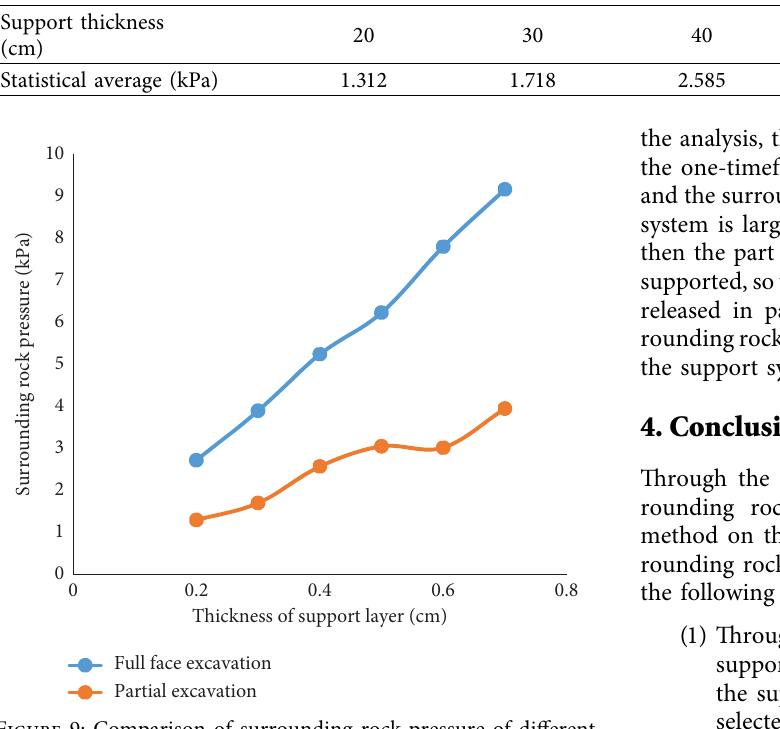
Figure 8: Distribution characteristics of surrounding rock pressure of support structure with diferent thicknesses of subexcavation: Table 6: Statistical average value of surrounding rock pressure of subexcavation.